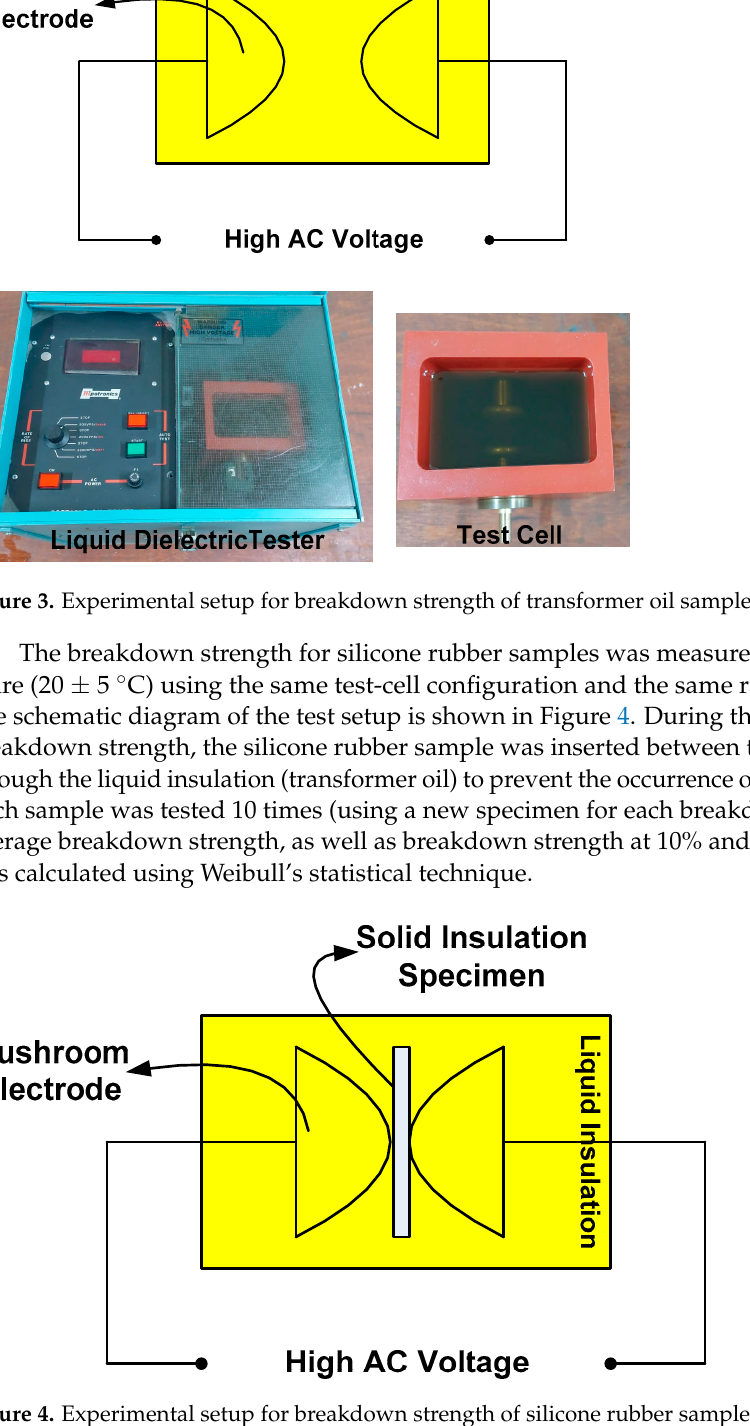
Figure 4. Experimental setup for breakdown strength of silicone rubber samples.